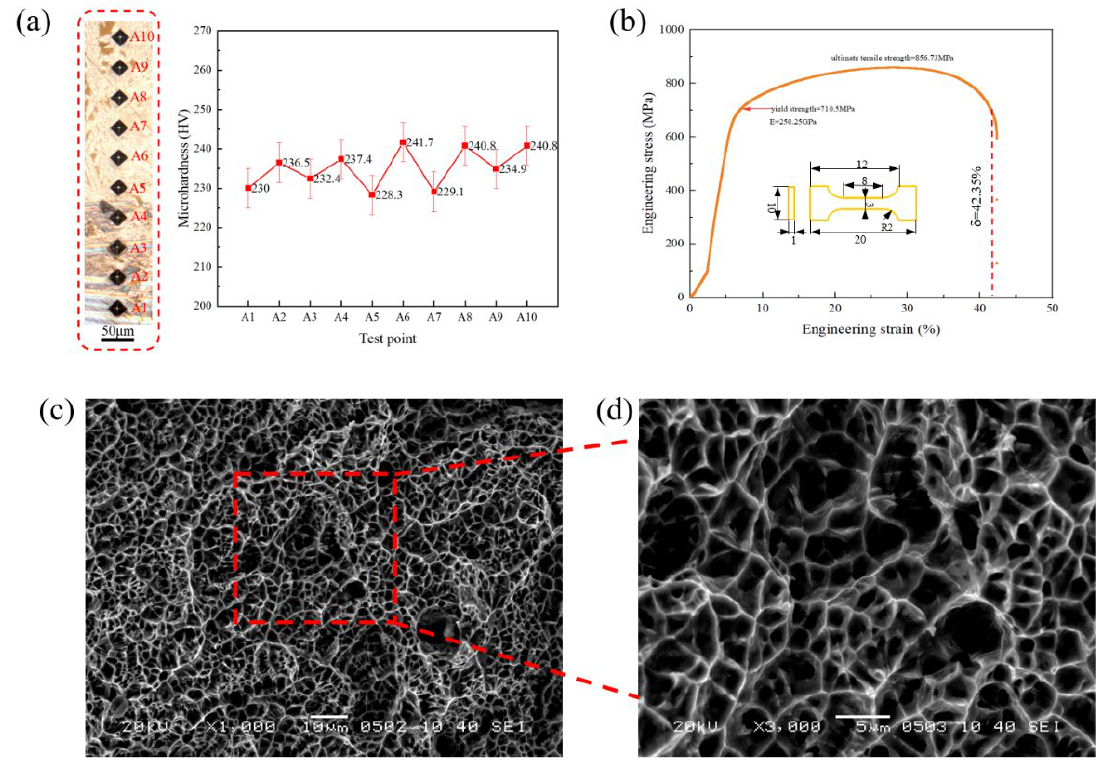
Figure 6. Mechanical properties. ( a ) Microhardness test. ( b ) Tensile test. ( c , d ) SEM fracture morphol- ogy diagram.